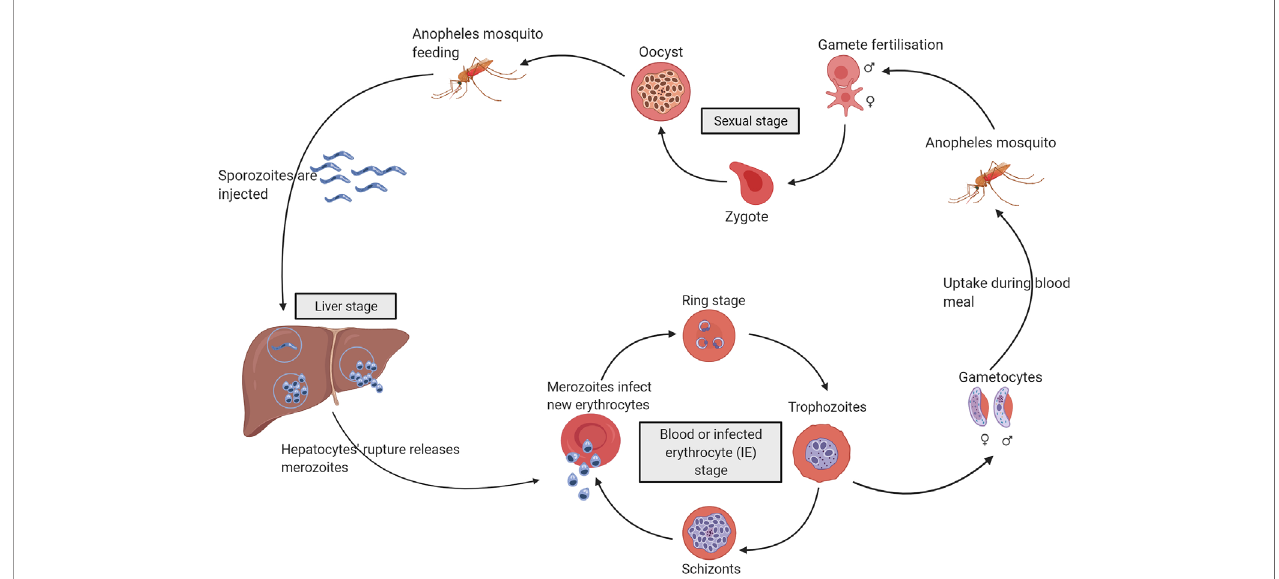
FIGURE 1 | The life cycle of Plasmodium falciparum. P. falciparum requires two hosts to complete its life cycle, the mosquito, and the human. Gametocytes are ingested by a female Anopheles mosquito during a blood meal. The gametocytes transform into gametes that fertilise to form zygotes and migrate through the mosquito gut wall to form oocysts. The oocysts rupture and release sporozoites that reach the salivary gland of the mosquito ready to be transmitted into another human host. The injected sporozoites reach the liver, and within hepatocytes, the parasites undergo division (liver stage) before rupture to release merozoites into the bloodstream. The merozoites infect new erythrocytes to form ring-stage parasites that mature into trophozoites and schizonts within the infected erythrocytes (IEs). The rupture of schizonts releases a new generation of merozoites to infect erythrocytes (blood stage). A small proportion of these parasites develop into gametocytes within the IEs, which are ingested by a female Anopheles mosquito for the continuation of the life cycle [reviewed in